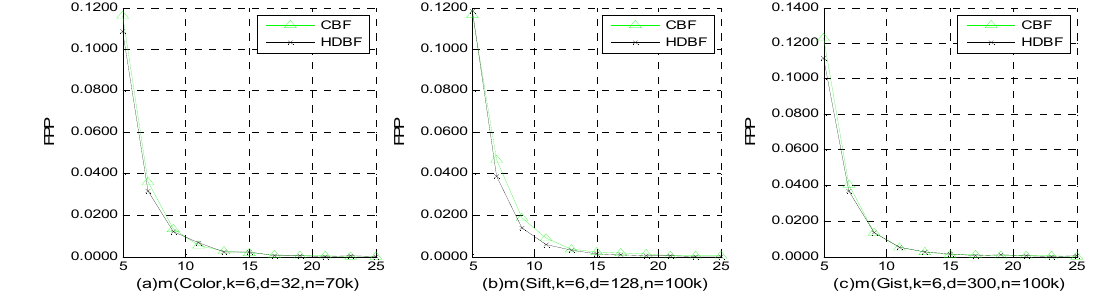
Figure 7. FPPs of the CBF and HDBF for different memory costs.